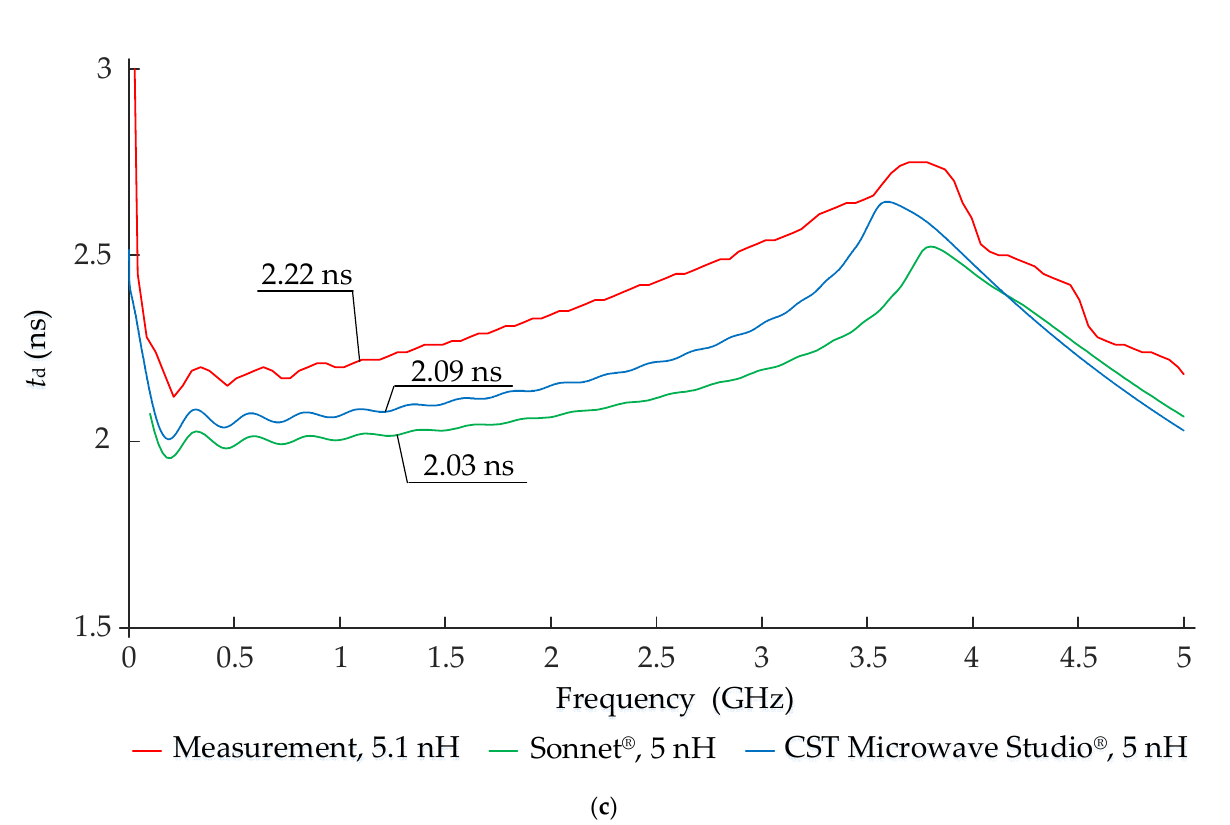
Figure 6. Comparison of the computer-based modeling results from Sonnet ® and CST Microwave Studio ® with the results of the physical experiment of the ( a ) S 21 , ( b ) S 11 , and ( c ) t d characteristics of the hybrid meander structure when the lumped inductive elements are 5 nH.